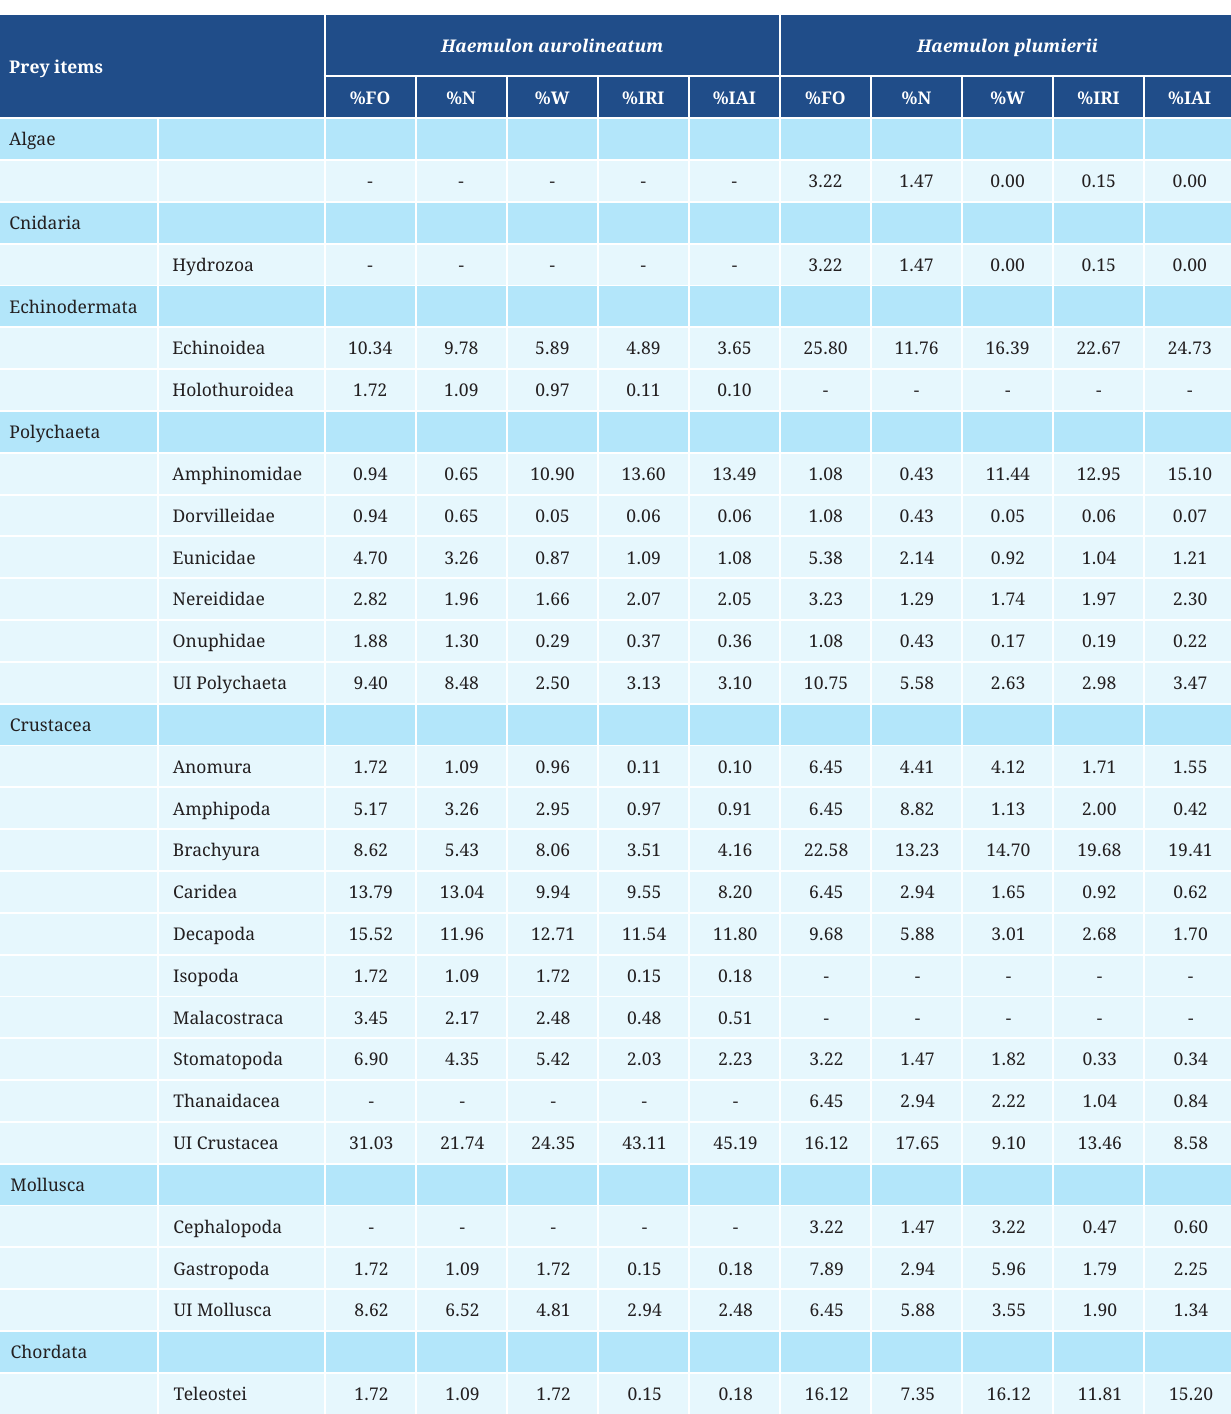
TABLE 1 | Contribution of each item of prey to the Haemulon aurolineatum and H. plumierii diets in the Southtern Atlantic considering the frequency of occurrence (%FO), number (%N), weight (%W) and respective relative importance (IRI) and food intensity (%IAI) (UI: